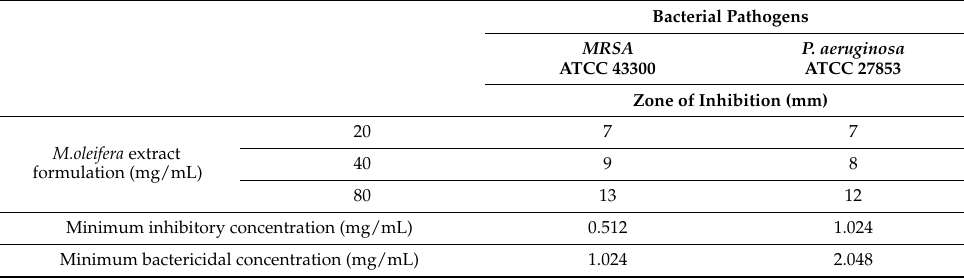
Table 2. Antibacterial activity of the formulation of M. oleifera extract against bacterial